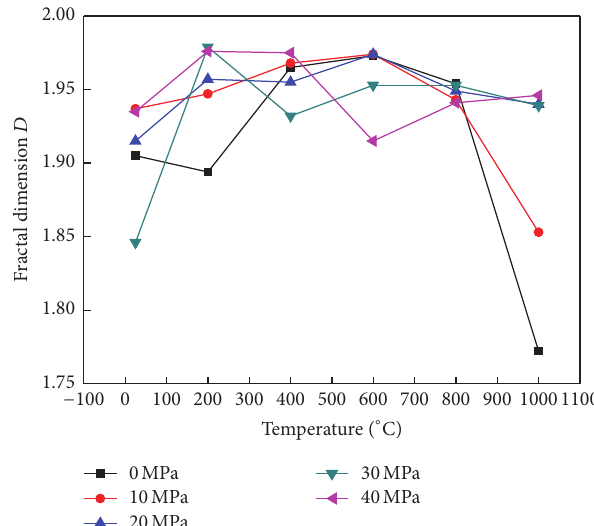
Figure 4: Relationship between fractal dimension and temperature under confining pressure at all